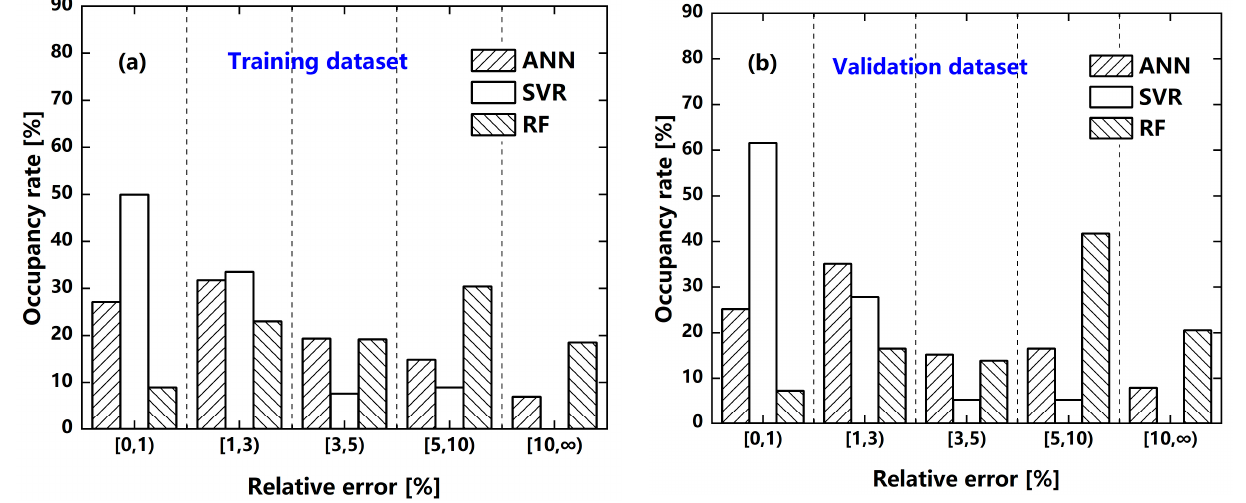
Figure 6. Occupancy rate in different error selection ranges based on three kinds of ML models: ( a ) training dataset; ( b ) validation dataset.